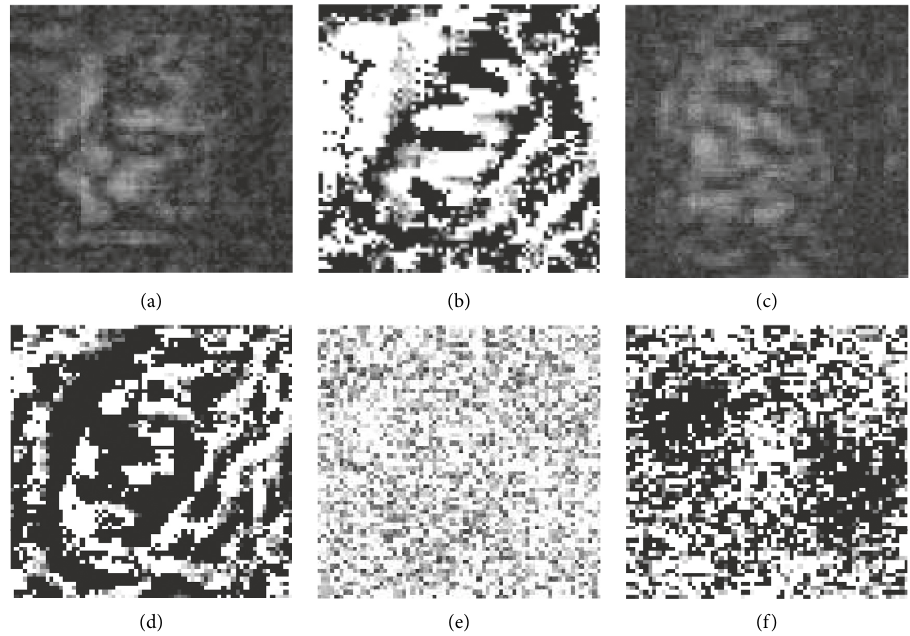
Figure 5: Decryption results using incorrect keys with 64 × 64 × 50% measurements: (a) reconstructed intensity distribution when one of RPM 2 is wrong and (b) the corresponding phase, (c) reconstructed intensity distribution when one of the d and (d) the corresponding phase, and (e) reconstructed intensity distribution when the measurement matrix Ψ is incorrect and (f) the corresponding